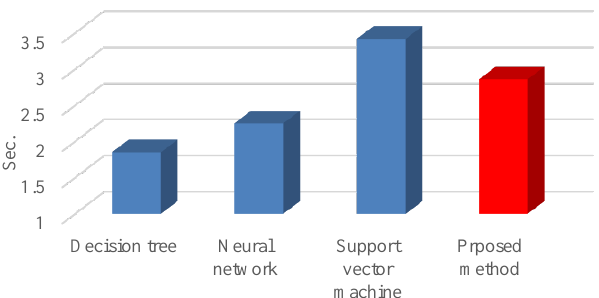
Figure 14. Comparing the runtime of the proposed algorithm with other